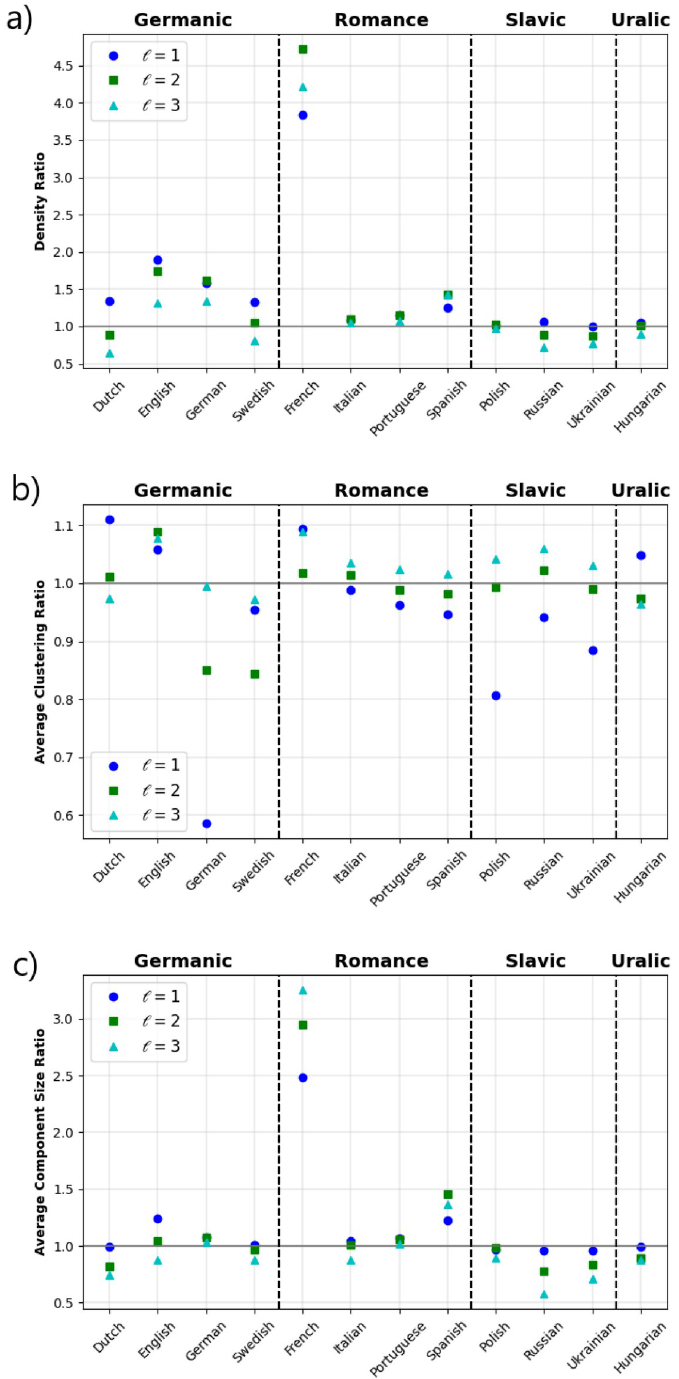
Fig 2. Ratio (phonological/orthographic) values for some metrics shown in Table 1. The cases of (a) density, (b) average clustering, and (c) average component size are depicted. Here a value close to 1 indicates that similar metric- values are obtained either for the ortographic or phonological layer, while a value greater (smaller) than 1 is obtained when the phonological (orthographic) exceeds the opposite layer. It is observed that French exhibits the highest asymmetry for density and component size, while for clustering, most languages display values close to 1, except German with higher values in the orthographic layer.